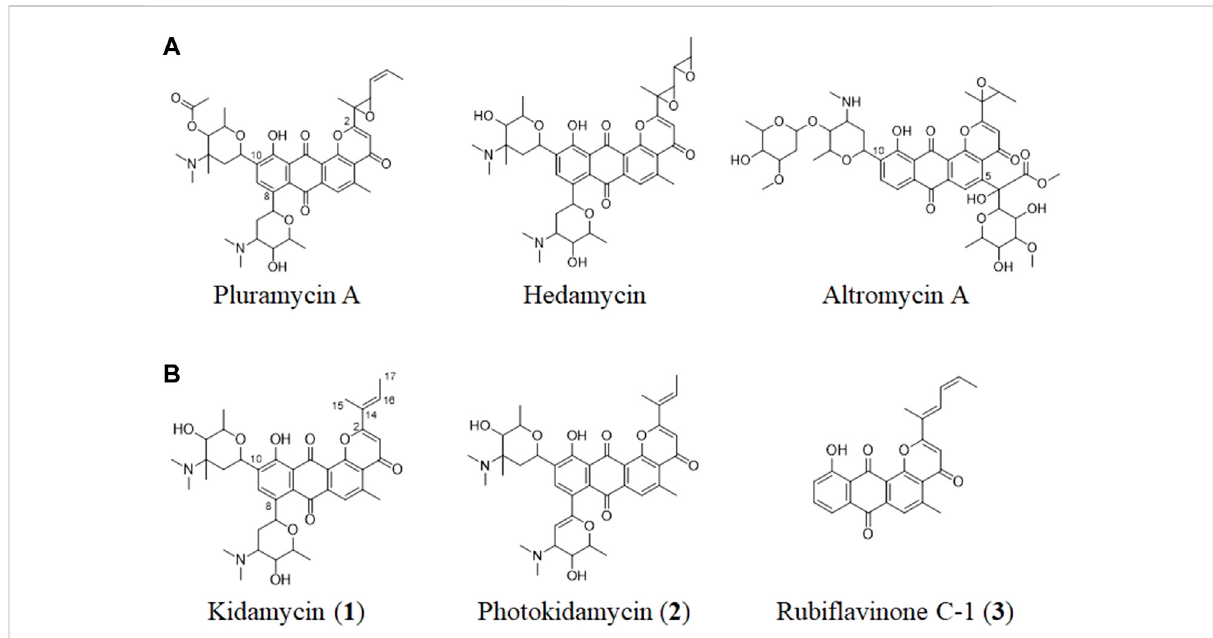
FIGURE 1 (A) Structuresofrepresentativepluramycinfamily angucyclinesand (B) thekidamycin( 1 ),photokidamycin ( 2 ),andrubi fl avinoneC-1( 3 )isolated from Streptomyces sp.